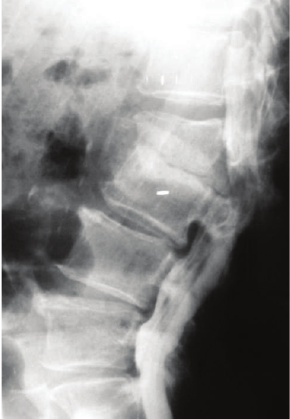
Figure 2: Preoperative plain radiograph (lateral view) showing marked narrowing of L2-L3 disc space with some endplate destruc- tion; new bone formation is noted (Case